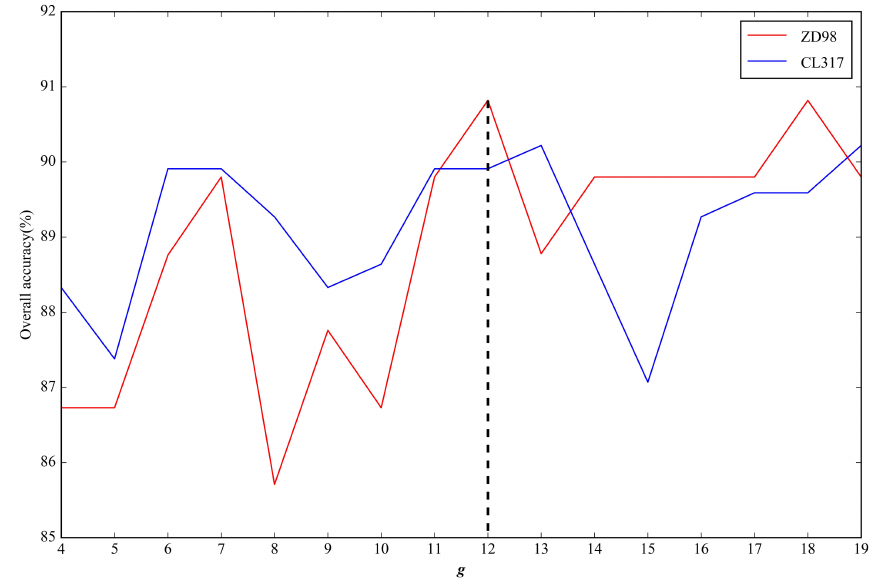
Figure 2. The effects of g on overall accuracy based on the datasets ZD98 and CL317 after ACC transformation of the physicochemical property matrices.